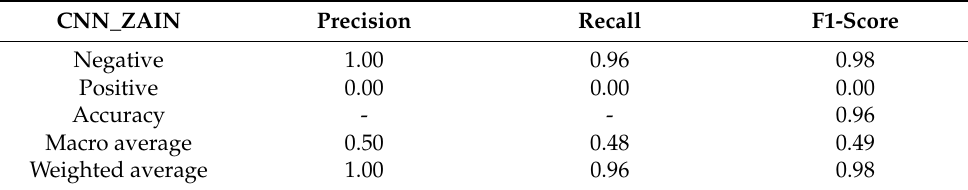
Table 4. Confusion Matrix obtained by CNN on the Zain dataset.